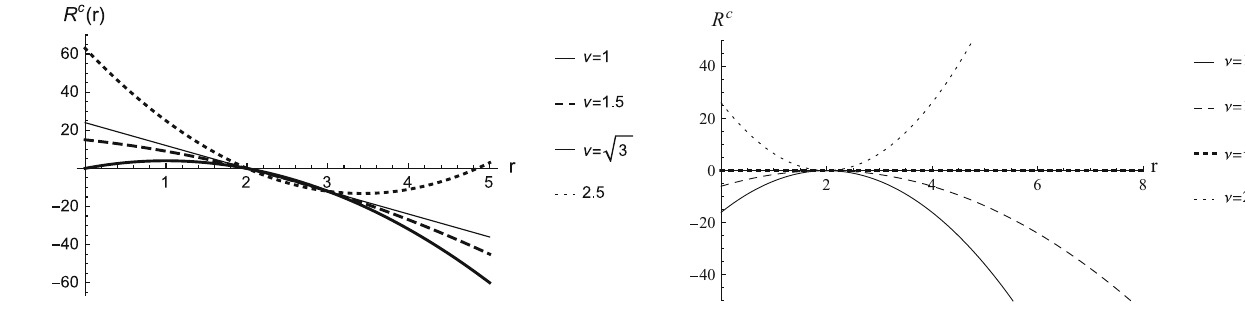
√ Fig. 6 Thebehaviorof R c ( r ) asafunctionof r fortheextremalwarped = − 1 . 380 ) , ν = 3 ( L c = c AdS 3 black hole for different values of the warped parameter ν = 1 ,ν = 1 . 5 ( L c = − 0 . 709 ), ν = − 1 . 959 ) , E = 1 and l =